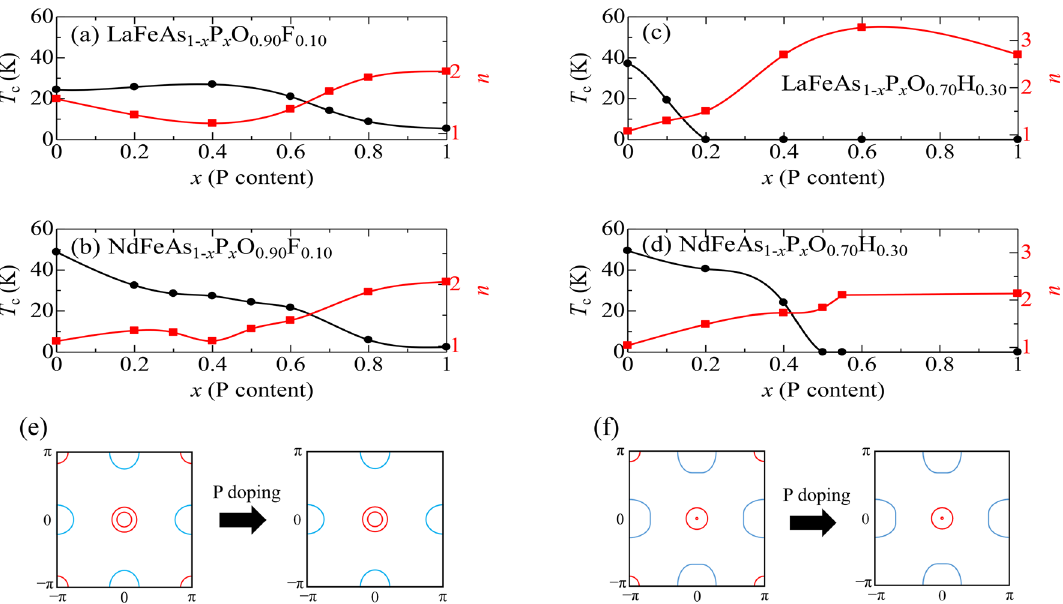
Figure 3. P concentration x -dependence of T c (black circles) and n in ρ( T ) = ρ 0 + AT n (red squares), and schematic Fermi surfaces, for y = 0.1 and 0.3. ( a ) LaFeAs 1 − x P x O 0.90 F 0.10 . ( b ) NdFeAs 1 − x P x O 0.90 F 0.10 . ( c ) LaFeAs 1 − x P x O 0.70 H 0.30 . ( d ) NdFeAs 1 − x P x O 0.70 H 0.30 . Solid lines are visual guides. ( e , f ) Schematic Fermi surfaces. Solid red and blue lines indicate hole and electron Fermi surfaces,